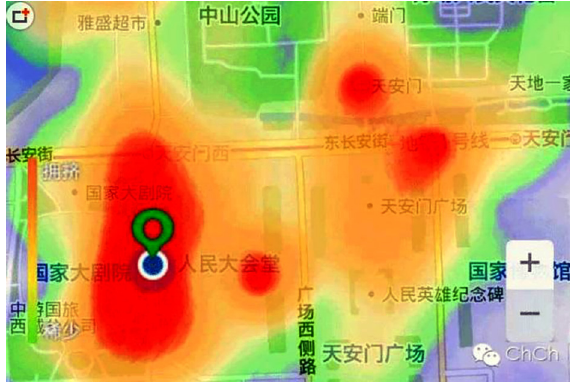
Figure 3. A fragment of a heatmap (pedestrian traffic jams on the roads) (Chuansong,